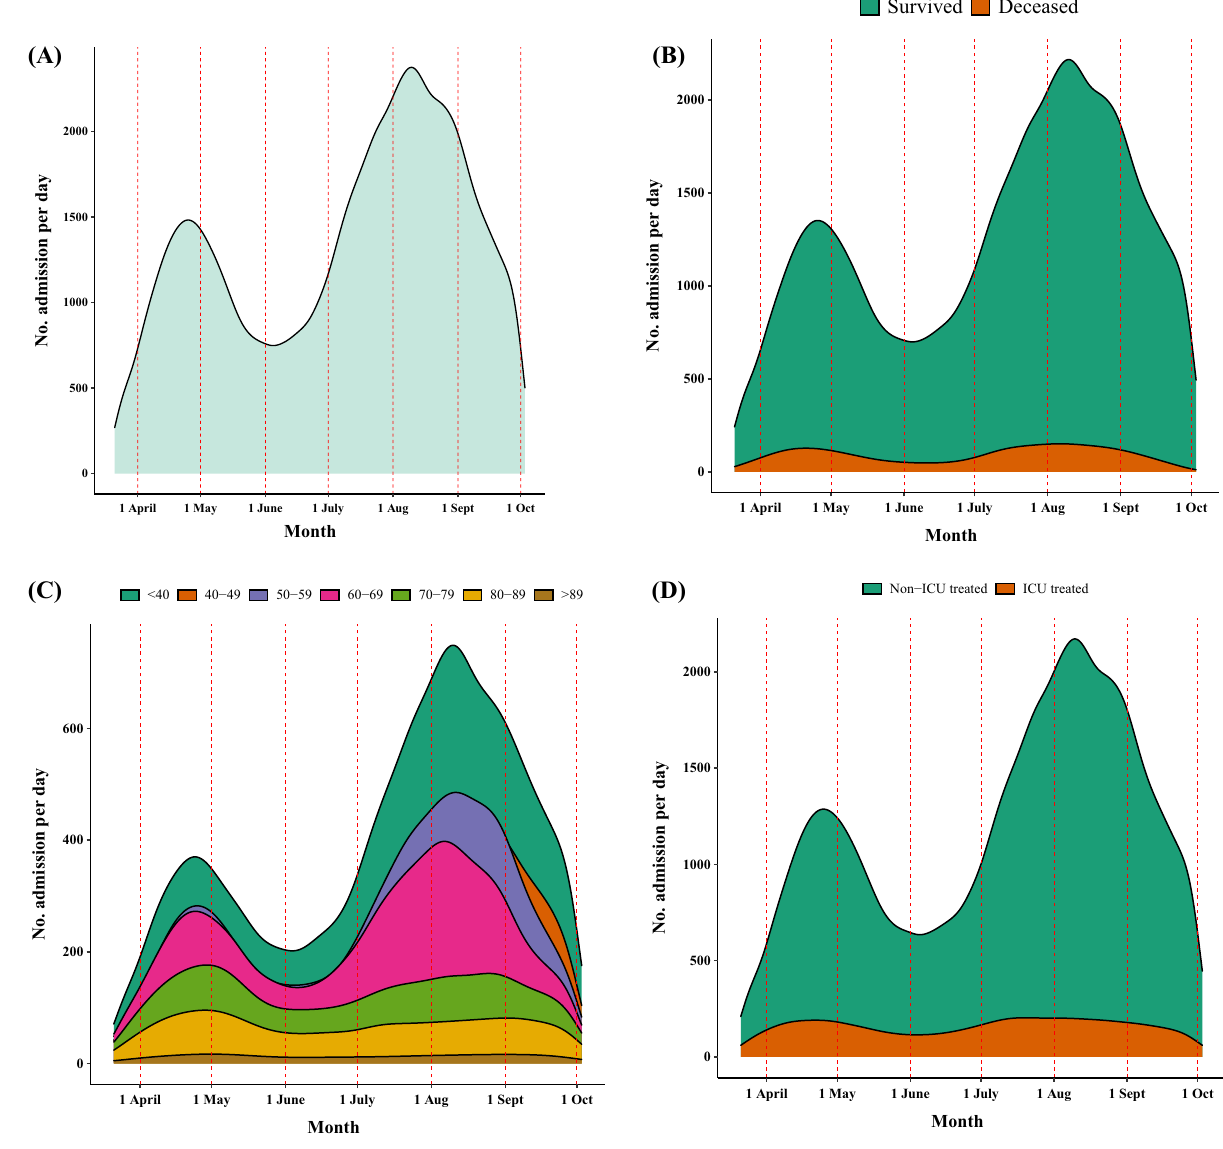
Figure 1. Density plot of patients’ frequency per Month during the study period. ( A ) Hospital admissions per month, ( B ) by death status, ( C ) by age group, and ( D ) by wards of